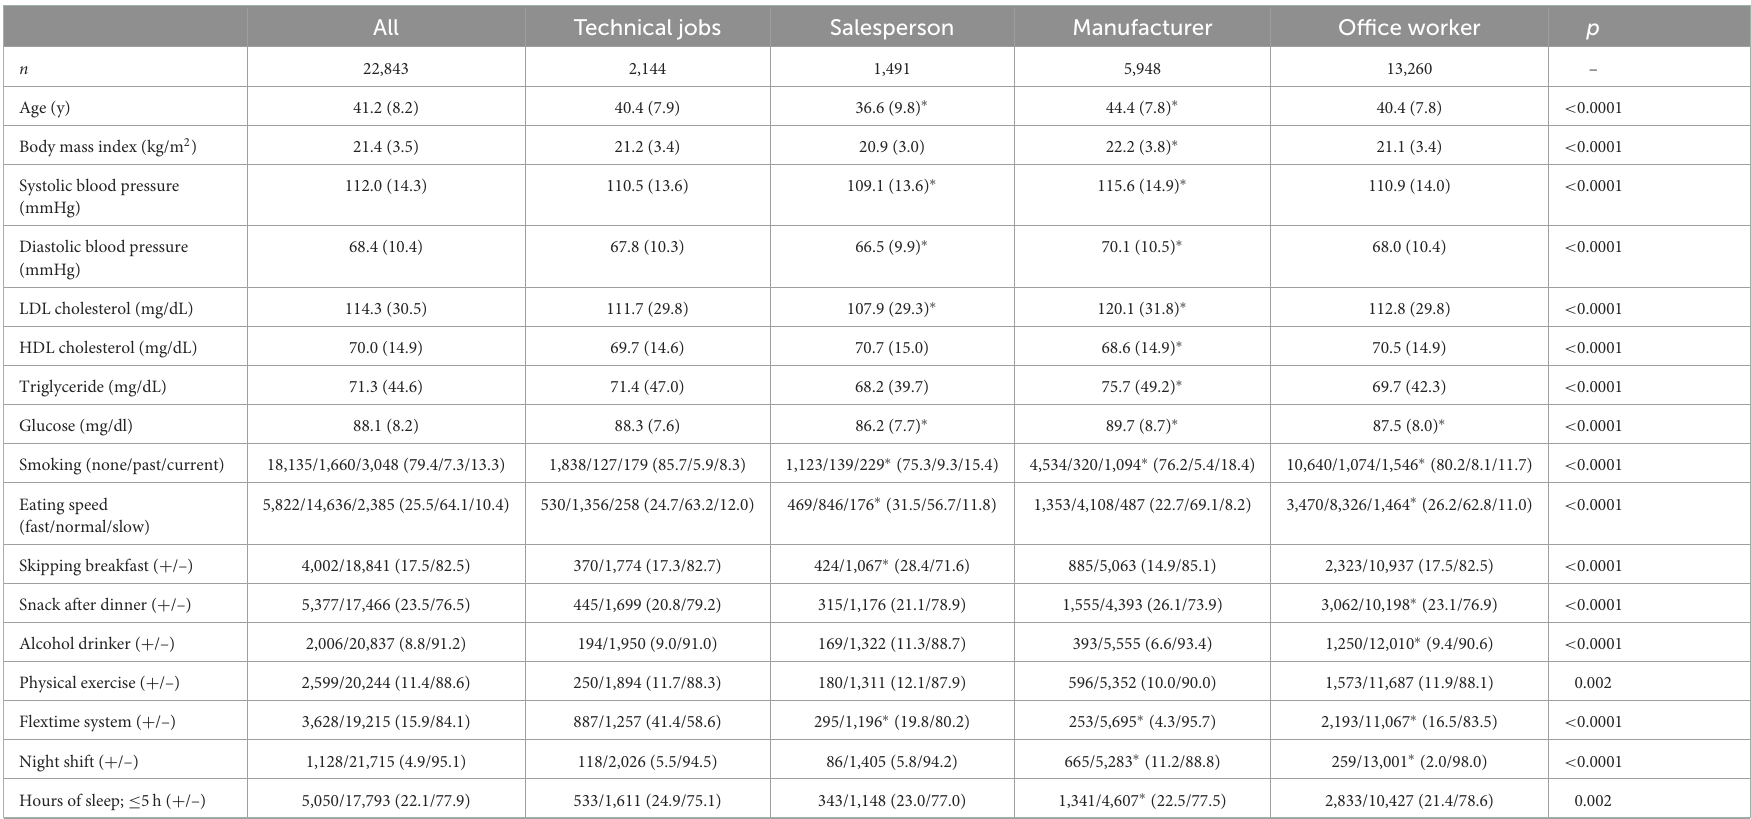
TABLE 2 Characteristics of patients at baseline according to occupation type in women. All Technical